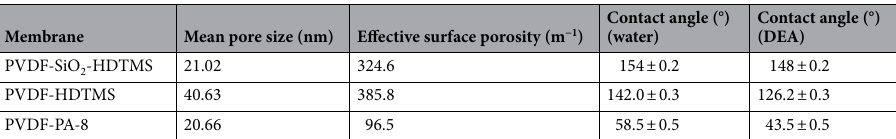
Table 5. Characteristics of the hollow fiber